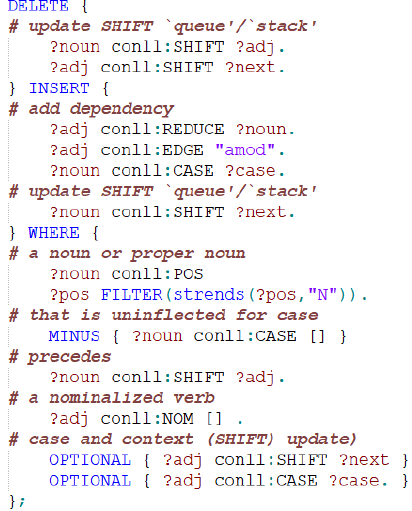
Figure 5. Adjective attachment rule in SPARQL Update, corresponding to NOUN 0 ADJ CASE ⇒ NOUN CASE amod ←−−−